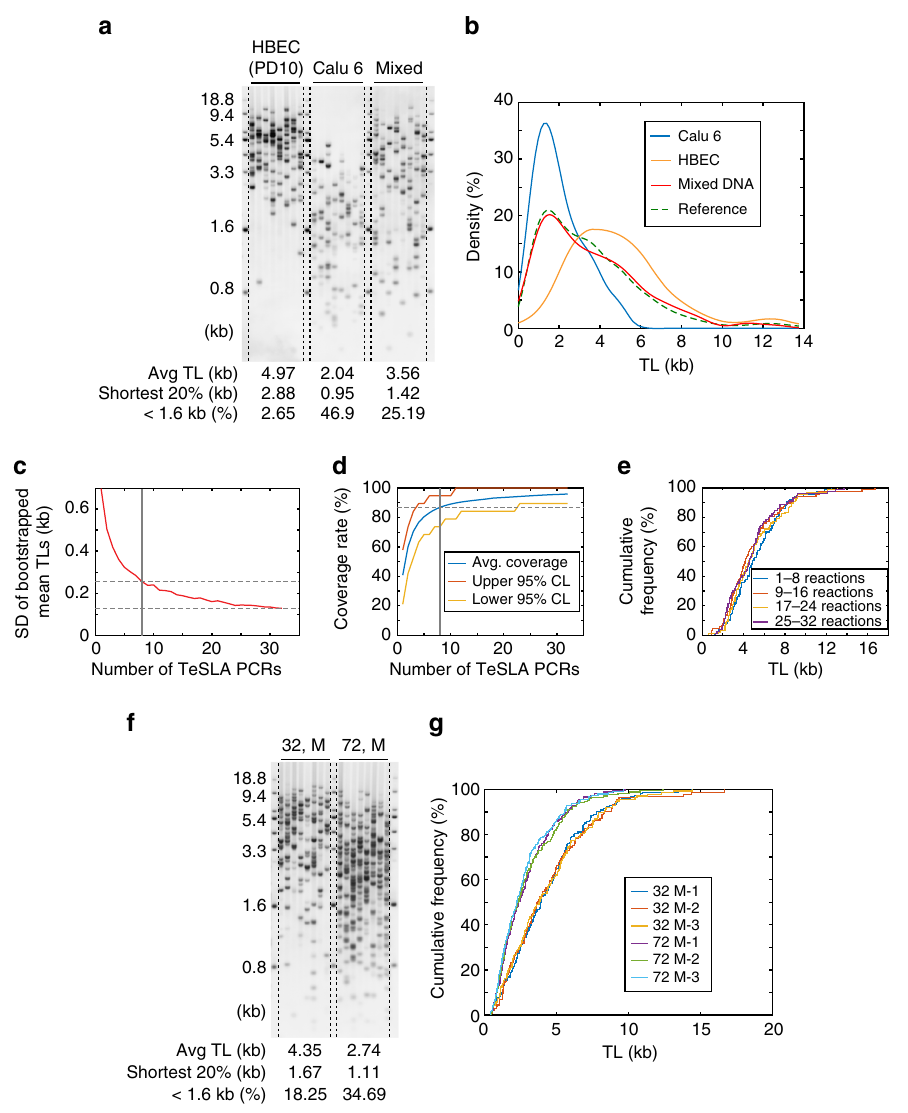
Fig. 4 Assessment of different variations of TeSLA. a TeSLA of human bronchial epithelial cells (HBECs), Calu 6 (lung cancer cell line), and mixed DNA (HBEC: Calu 6 = 1:1) using 30 pg of DNA for each TeSLA PCR. b The kernel density estimation of TL from TeSLA results of Calu 6 (blue), HBEC (orange), and mixed DNA (red). The reference line (green dashed) represents a theoretical density function of TeSLA results when HBEC: Calu 6 = 1:1. c Standard deviations of bootstrapped distributions of mean TLs computed from 32 TeSLA PCRs of HBECs (Supplementary Fig. 4a) show the estimation accuracy achieved by using n (1 ≤ n ≤ 32) lanes to estimate the mean TL. d Coverage rates estimated from 32 TeSLA PCRs of HBECs (Supplementary Fig. 4a) based on bootstrapping. When eight PCRs were randomly selected from the 32 PCRs, 87% of all telomeres were detected with bin sizes 0.5 kb ranging from 0 to 10 kb. Red (yellow) line indicates upper (lower) 95% con fi dence bounds of the coverage rates. e Empirical distribution curves of quadruplets (eight TeSLA PCRs of each) from TeSLA results for HBECs show no signi fi cant changes in each eight TeSLA PCRs. f Representative TeSLA results of PBMCs from a young (age 32) and an old (age 72) individual. g Empirical distribution curves of TLs from the TeSLA of the triplicate results (blue, red, and yellow lines) for the 32-year-old male and triplicate results for the 72-year-old male (purple, green, and sky blue